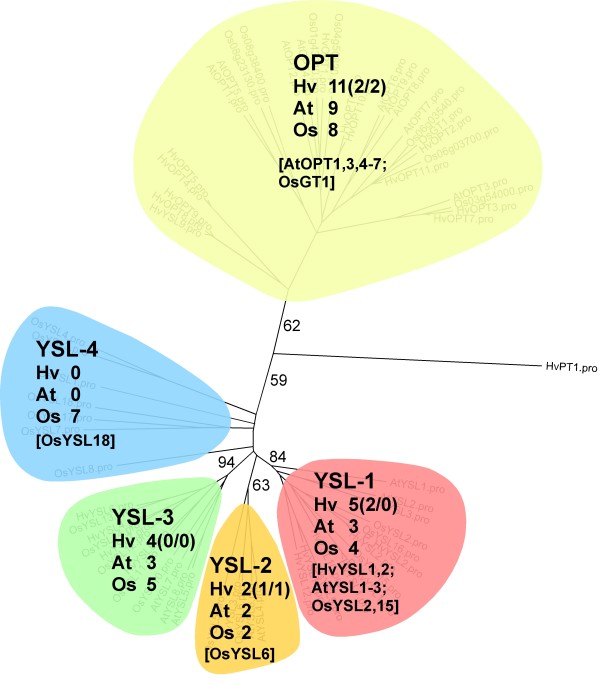
Phylogenetic tree of plant OPTs. Clustering of 17 Arabidopsis, 26 rice and 22 unique barley sequences. Colours indicate membership to the OPT (yellow) and the yellow stripe-like (YSL) family. According to Zheng et al. [26] YSL transporter sequences are subdivided into the subgroups YSL-1 (red), YSL-2 (orange), YSL-3 (green) and YSL-4 (blue). Barley sequences were derived from RNA-seq and publications (HvYSL1 + 2). Clustering of OPT sequences into different subgroups is supported by the sequence distance matrices (Additional file 6: Figure S6). Detailed version of the phylogenetic tree including ID-numbers of all sequences is given in Additional file 7: Figure S5. For further explanations see legend of Figure 6.